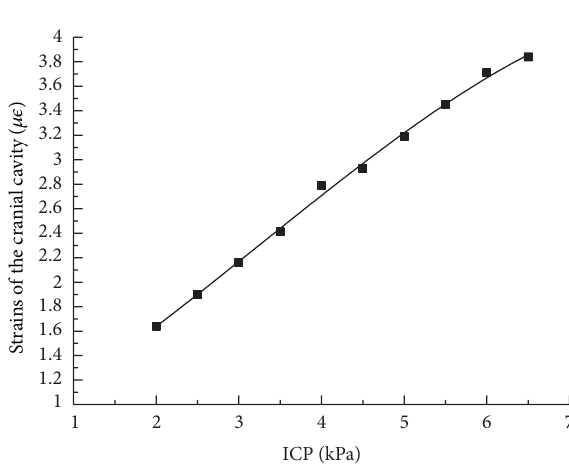
Figure 24: Strains curve of cranial cavity with the ICP